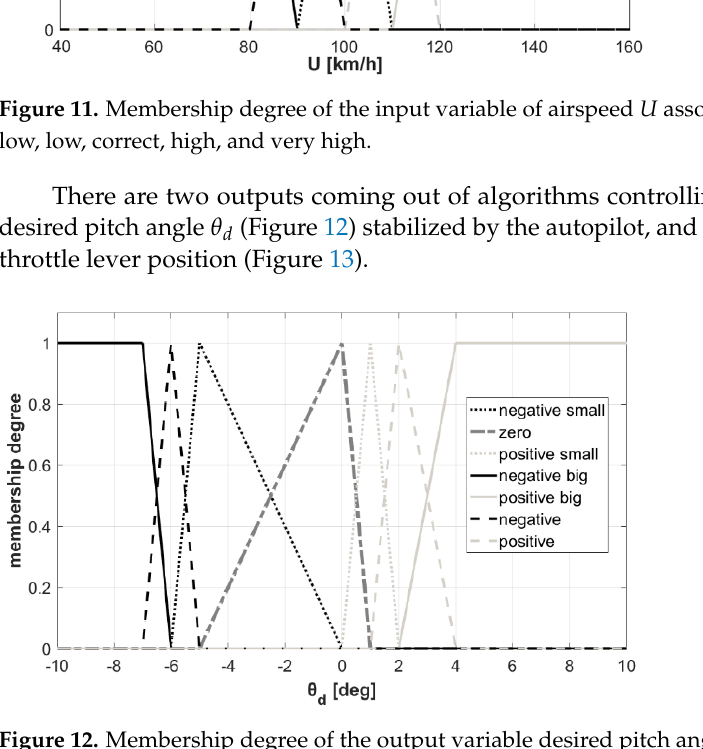
associated with fuzzy d